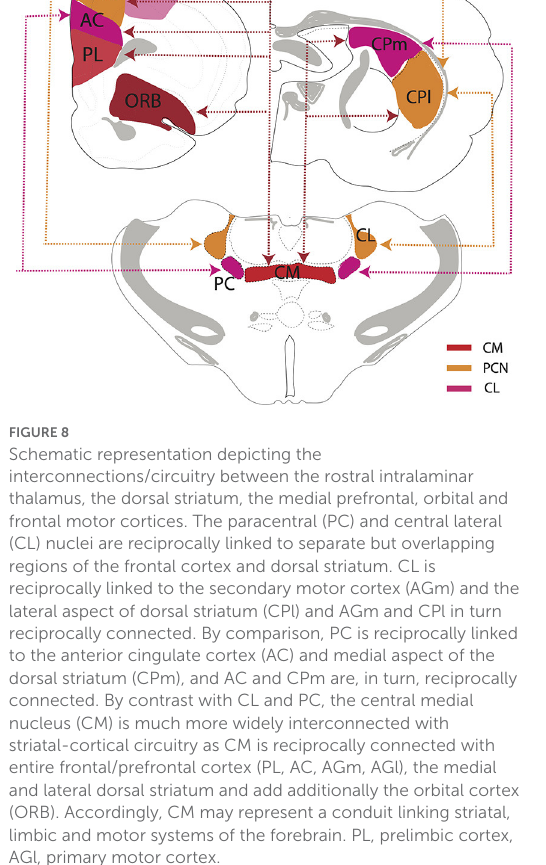
the hippocampus. Additionally, CL stimulation synchronized theta/alpha oscillations between the thalamus and striatum (thus strengthening their connections), upregulated dopamine D2 and cholinergic receptors in C-P and improved performance on an instrumental conditioning